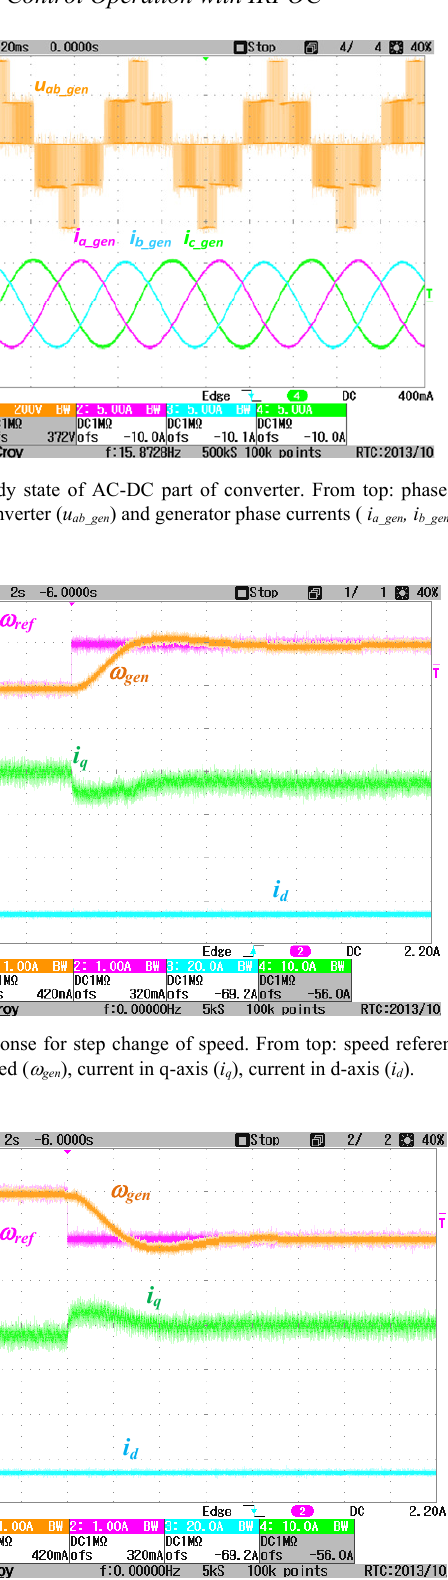
Fig. 16. Response for step change of speed. From top: reference speed ( ω ref ), estimated speed ( ω gen ), current in q-axis ( i q ), current in d-axis ( i d ).